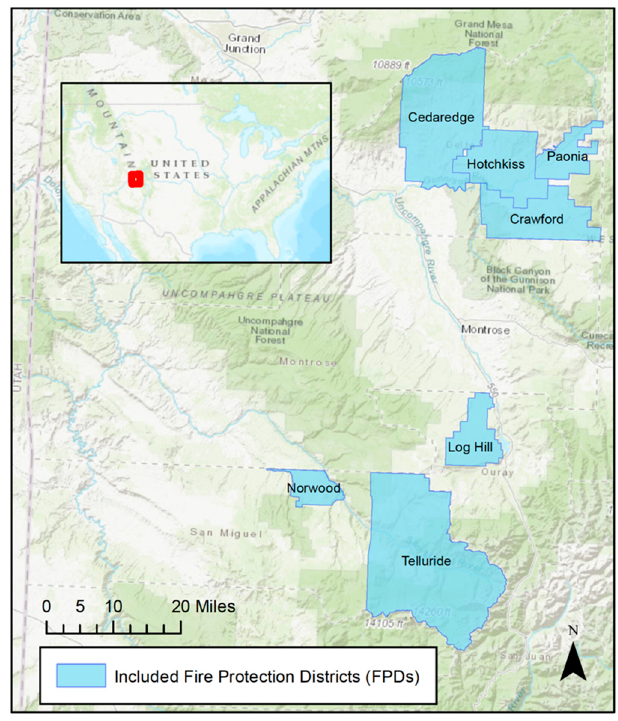
Figure 1. Western Colorado communities (FPDs) included in the experiment.